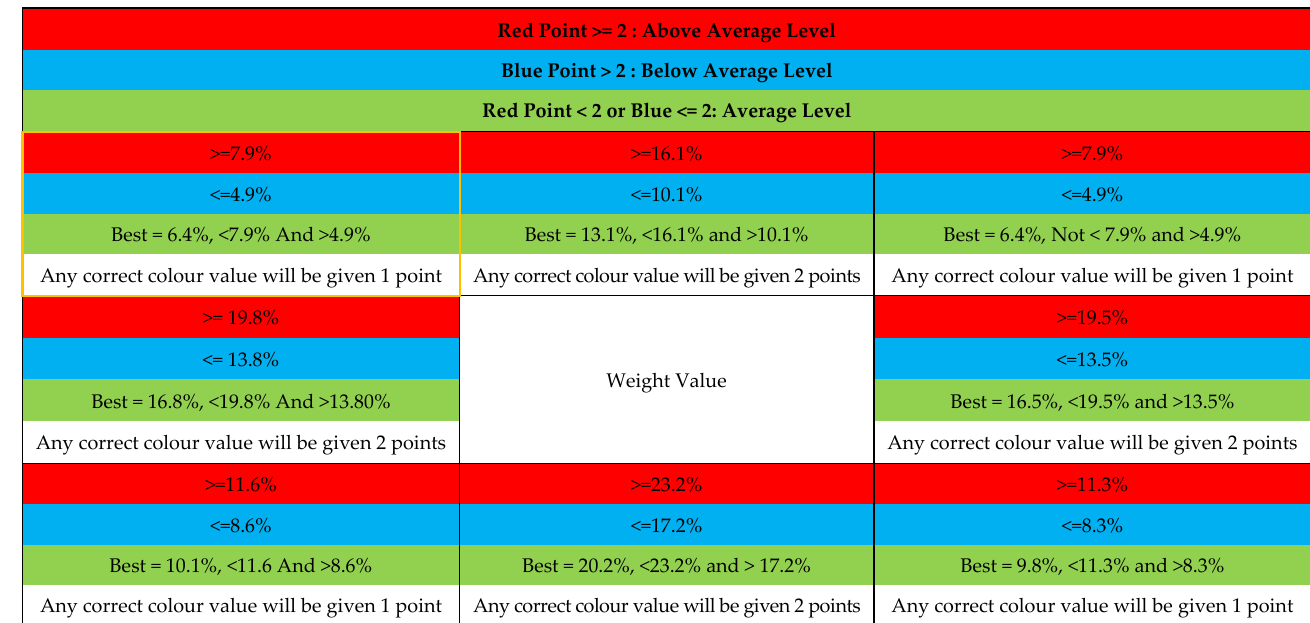
Table 1. The colour codes are based on the threshold for bodyweight percentage distribution detected by the load cells inside the platform.